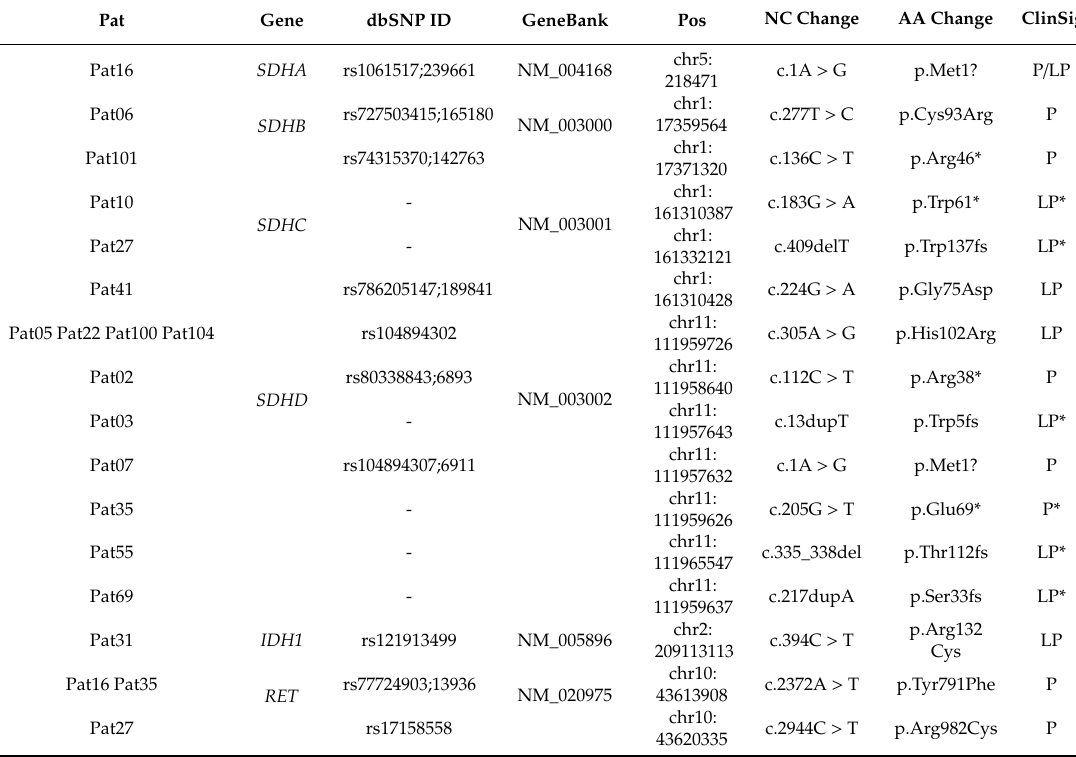
Table 1. Pathogenic / likely pathogenic variants in SDHx , RET , and IDH1 genes found in patients with carotid paragangliomas